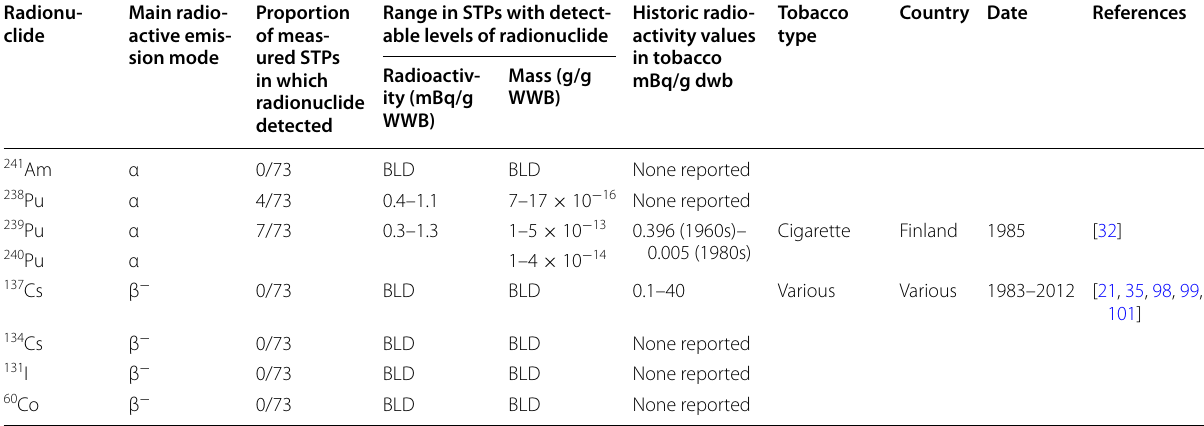
Table 4 Summary of current findings in contemporary STPs and historic values for anthropogenic